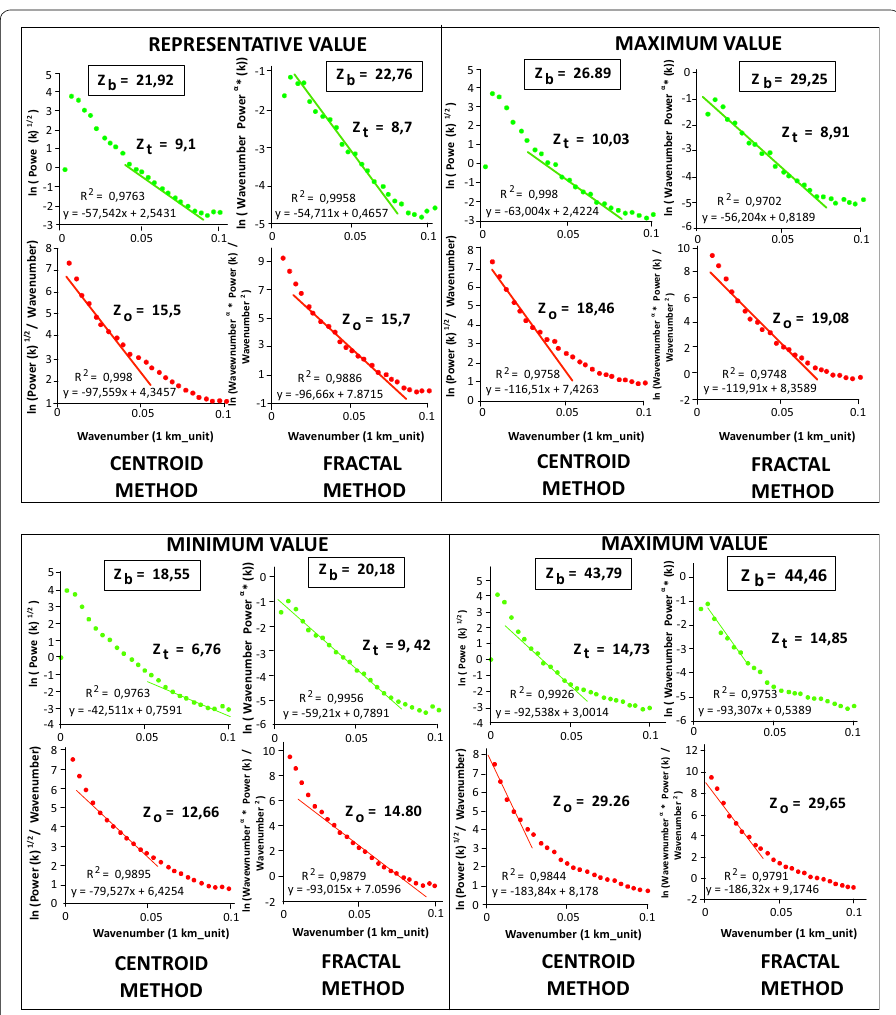
Fig. 3 Examples of spectra and respective CPD estimations for oceanic (Part 1) and continental (Part 2) zones. Only the long wavelength domain of the spectrum is presented. Points and lines in green, respectively, indicate the spectrum zone used to calculate the depth to the top ( Z t ) and the corresponding adjusted straight line. Points and lines in red, respectively, show the zone used to determine ( Z o ) and respective adjusted line. Equations of the adjusted lines and their respective correlation coefficients ( R 2 ) are given. At the left side of Part 1, representative CPD estimates (estimated values common for that area) shown for an oceanic area (estimations by both method) and for a maximum value (right side). Part 2 presents, for the continental area, CPD estimations, by both methods, for a minimal (left side) and for a maximal value (right